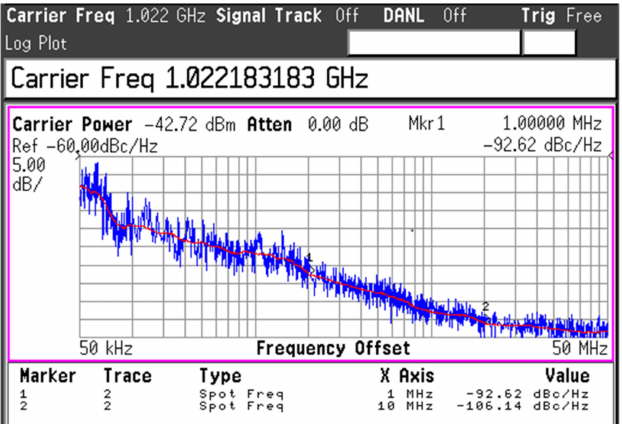
Figure 15. The measured phase noise of the stand-alone VCO.